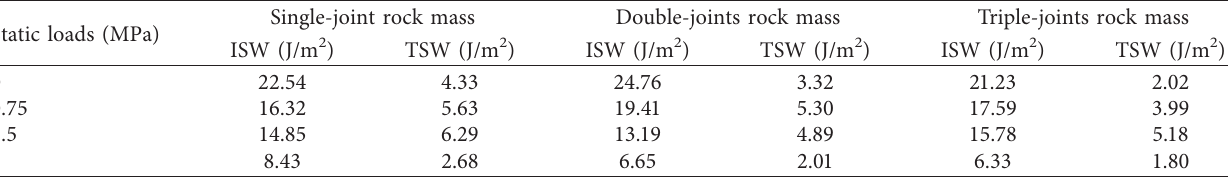
Table 3: Energy intensities of incident and transmitted stress wave under different equal biaxial static loads. Static loads (MPa)